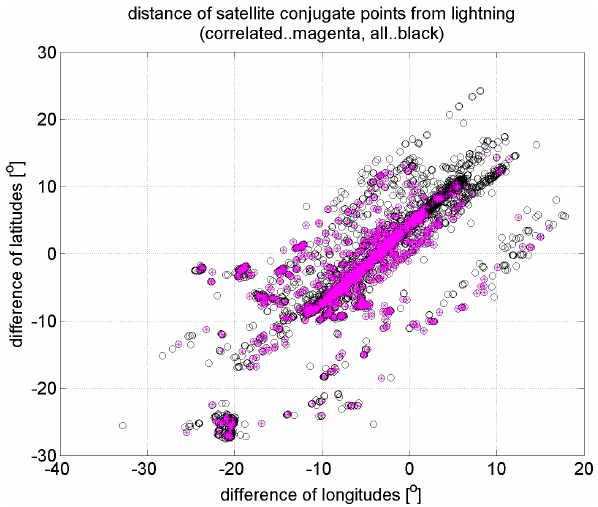
Fig. 5. Distances between the magnetic footprint of the satellite (at the altitude 110km) and the lightning discharges. Circles (black) are used for all lightning, asterisks (magenta) for those discharges for which the corresponding whistler was found. Positive value of the difference in latitudes (longitudes) means that the footprint was northward (eastward) from the